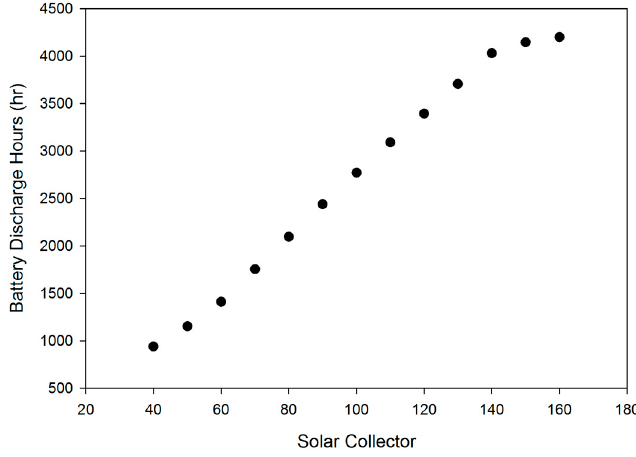
Figure 13. The number of battery discharge hours of the ORC-EES verses number of solar collectors for a restaurant in Tucson, AZ.